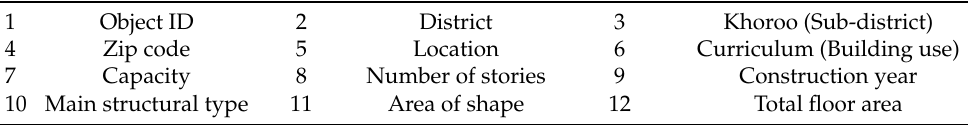
Table 1. List of building information of the existing inventory